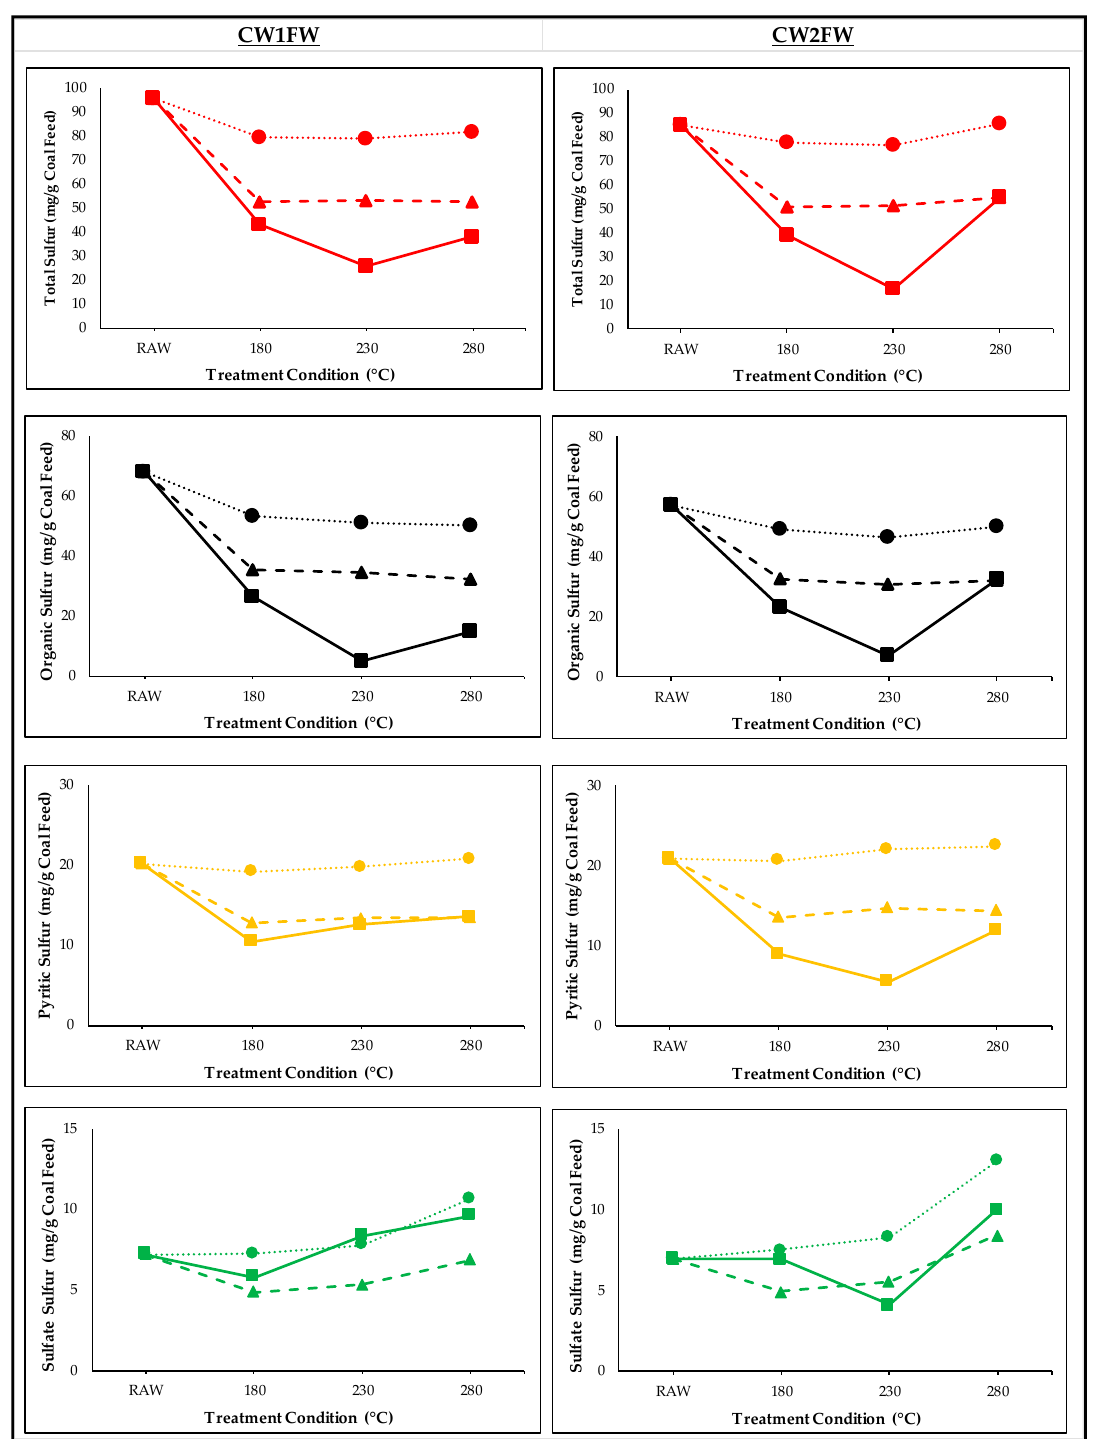
Figure 2. Absolute values of various forms of sulfur per coal feed under the Co-HTC treatment. The red, black, yellow, and green colors represent the total, organic, pyritic, and sulfate sulfur, respectively. The dotted line represents the CW, while the dashed and solid lines indicate the theoretically calculated and experimentally measured values, respectively.